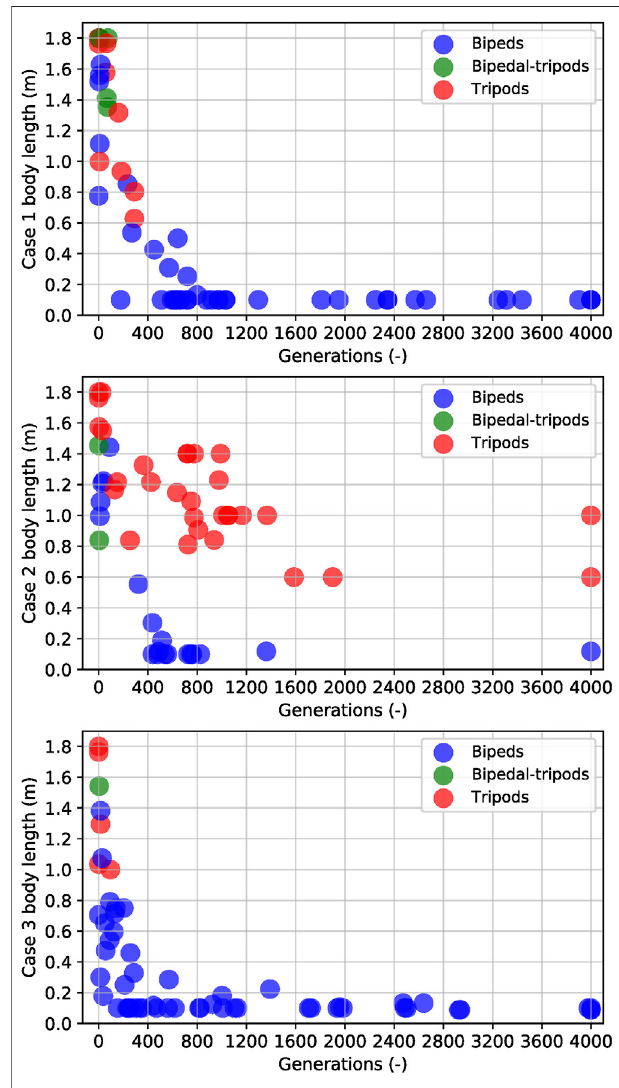
FIGURE8| Thescatter mapofallthreecasesinthreedifferenttrials with different body lengths at every bump of the current fi tness. Case 1 is the body length with free constraint during generations, Case 2 is the constraint body length with decreasing value during generations, and Case 3 is the constraint bodylengthbasedon thebest fi tness obtained during generations. Redstandsfortripods,greenforahybridbipedal-tripods,andblueforbipeds. Here,bipedal-tripodisthetransitionmorphologybetweenbipedsandtripods, while a creature walks supported with a long body occasionally. Since the simulations started from a tripod individual with the longest body length, the scatter map is red in the beginning. By growing with different body length constraint mechanisms, most individuals become bipeds (blue) at the